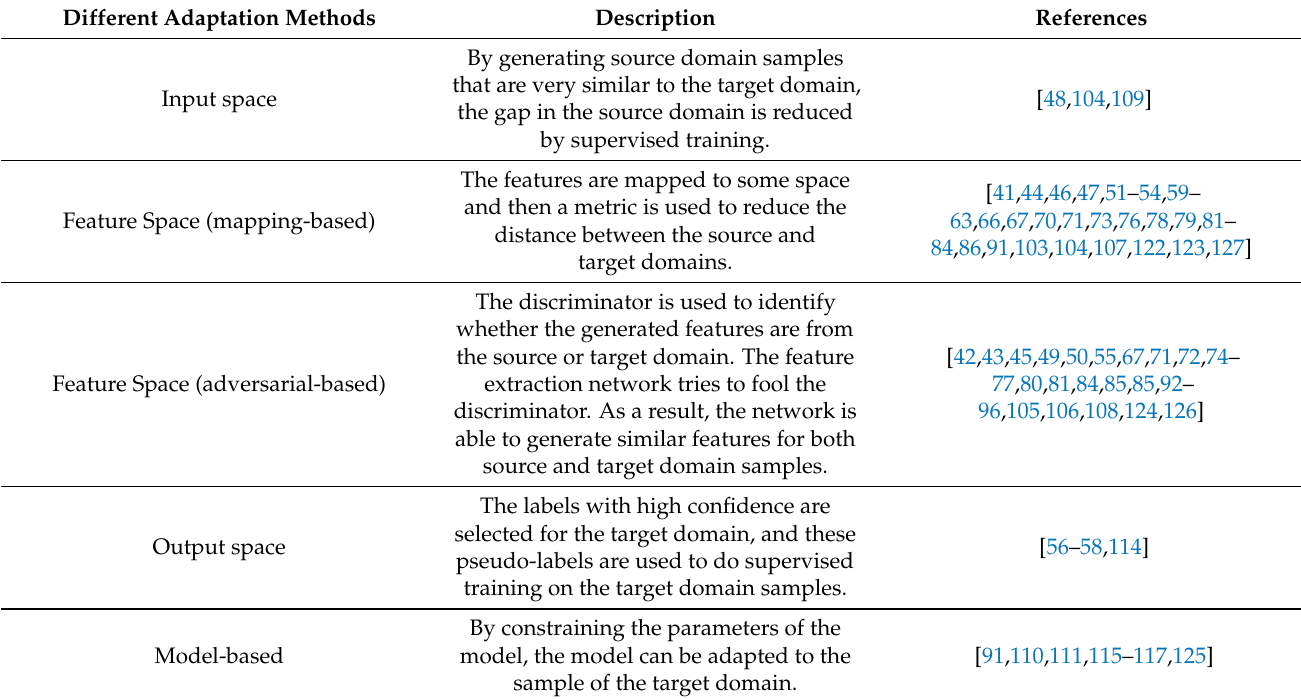
Table 2. The classification results based on different domain adaptation